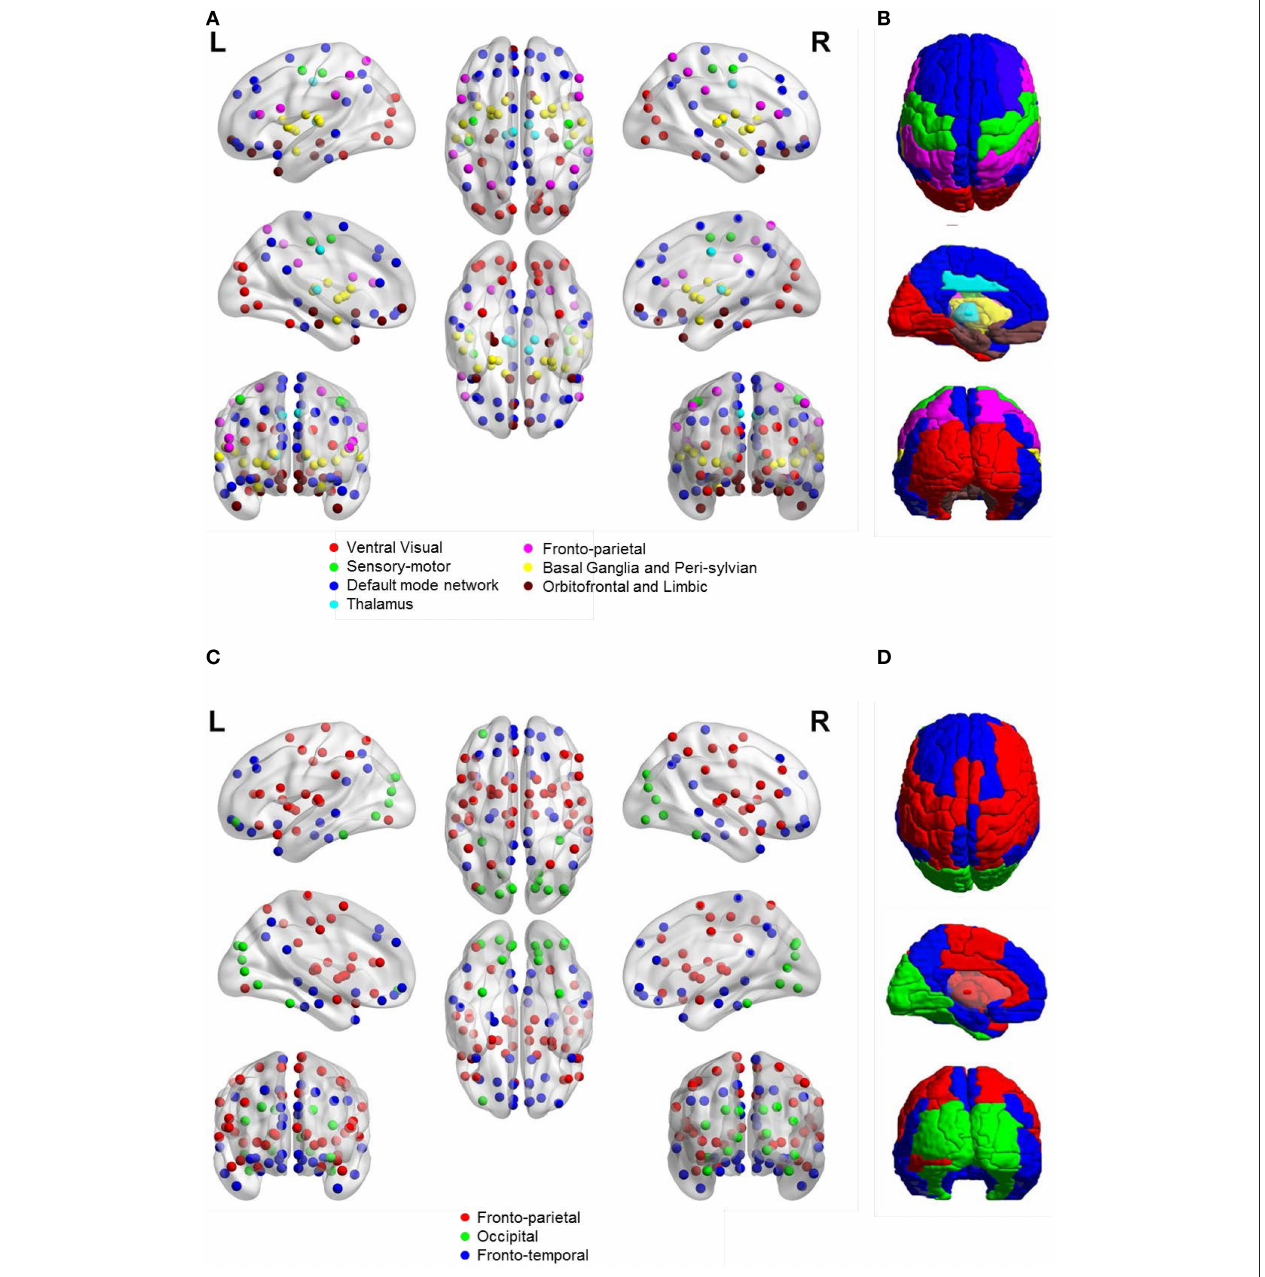
FIGURE 5 | Community structure of a functional network obtained by ASR and the Pearson correlation on a randomly chosen subject. (A) ASR with nodes shown. (B) ASR with ROIs shown. (C) Pearson correlation with nodes shown. (D) Pearson correlation with ROIs shown. We show the views of axial, coronal and sagittal for left and right hemispheres. Ninety nodes are shown, where each node represents a ROI in AAL template and nodes of the same color form one community. This figure is generated by using BrainNet Viewer (Xia et al.,